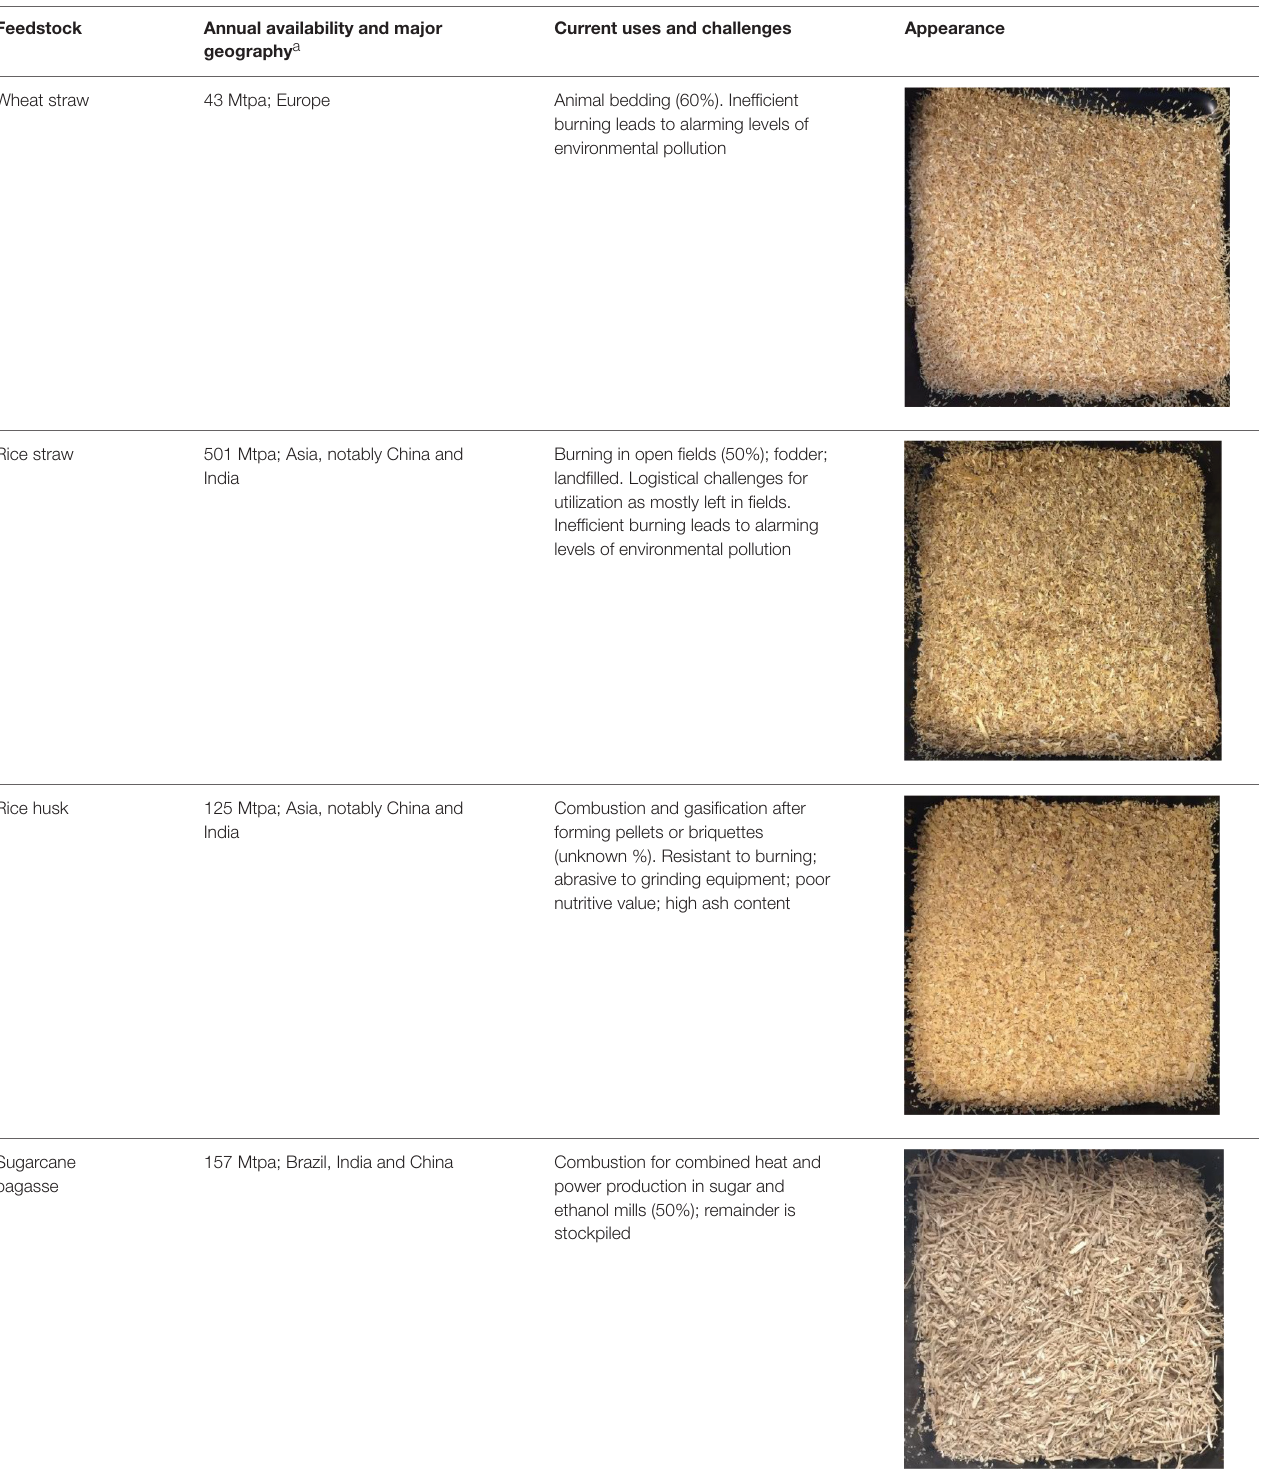
TABLE 1 | Agricultural residues investigated in the present study and their appearance after milling and before